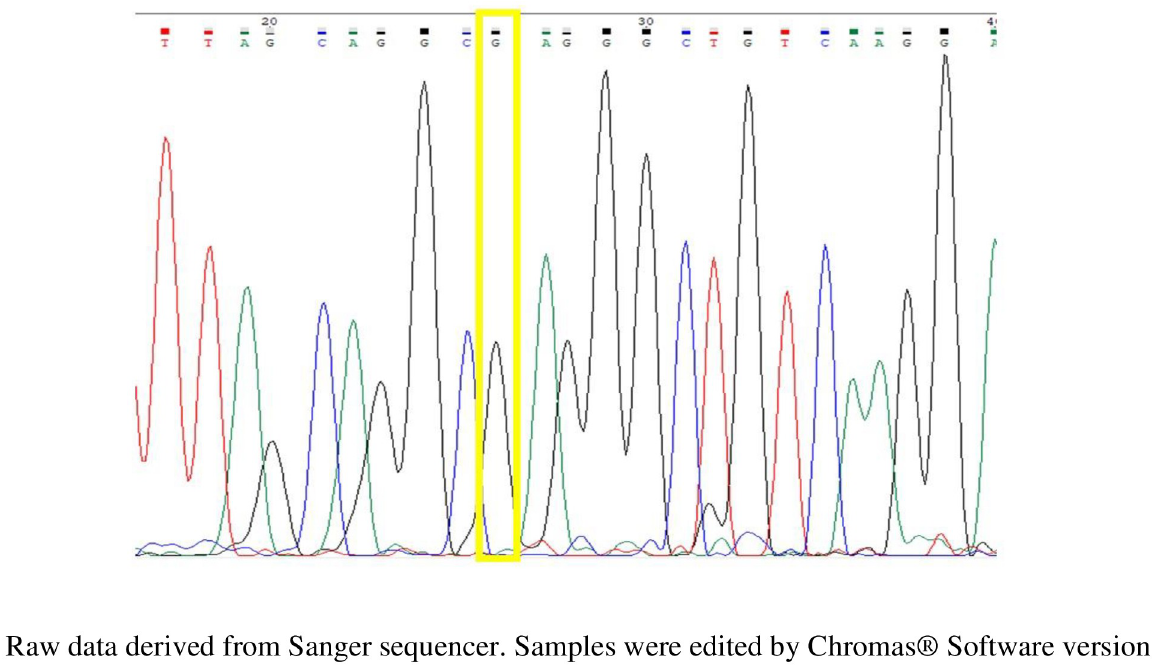
Fig 1. Sample of chromatogram data of rs10741657 showing G allele in location 26 bp.